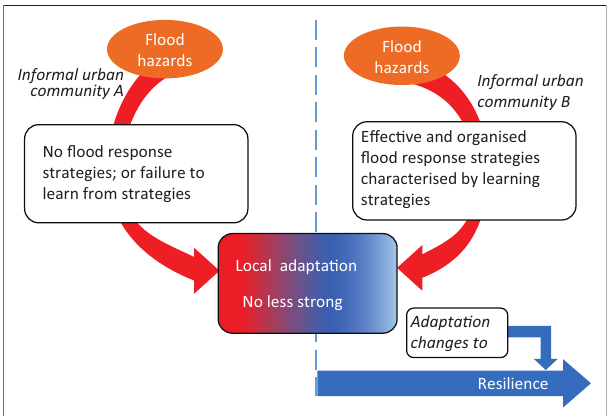
FIGURE 1: Local flood adaptation and